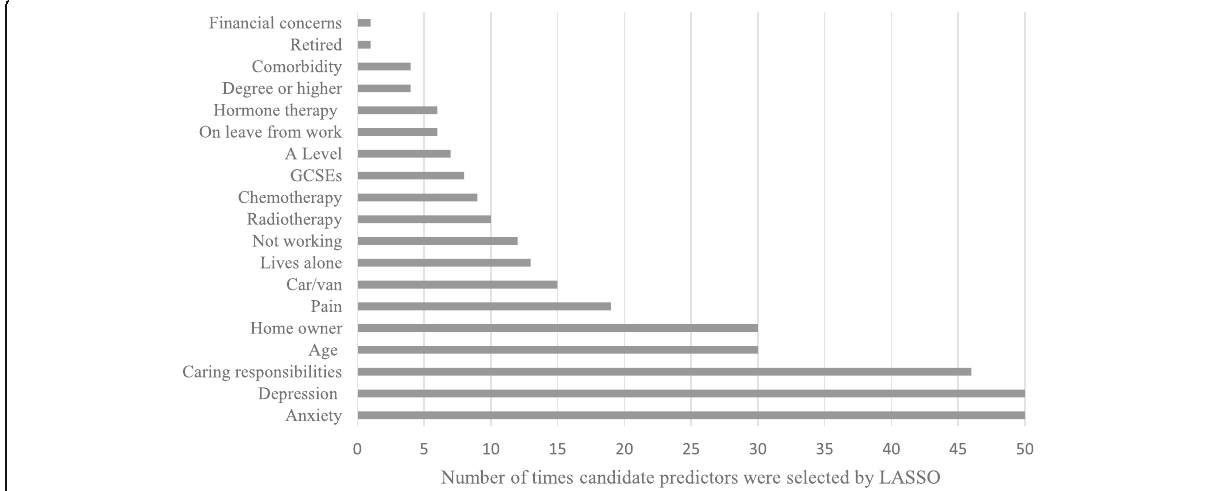
Fig. 2 Number of times candidate predictors were selected by LASSO in MI datasets (m =